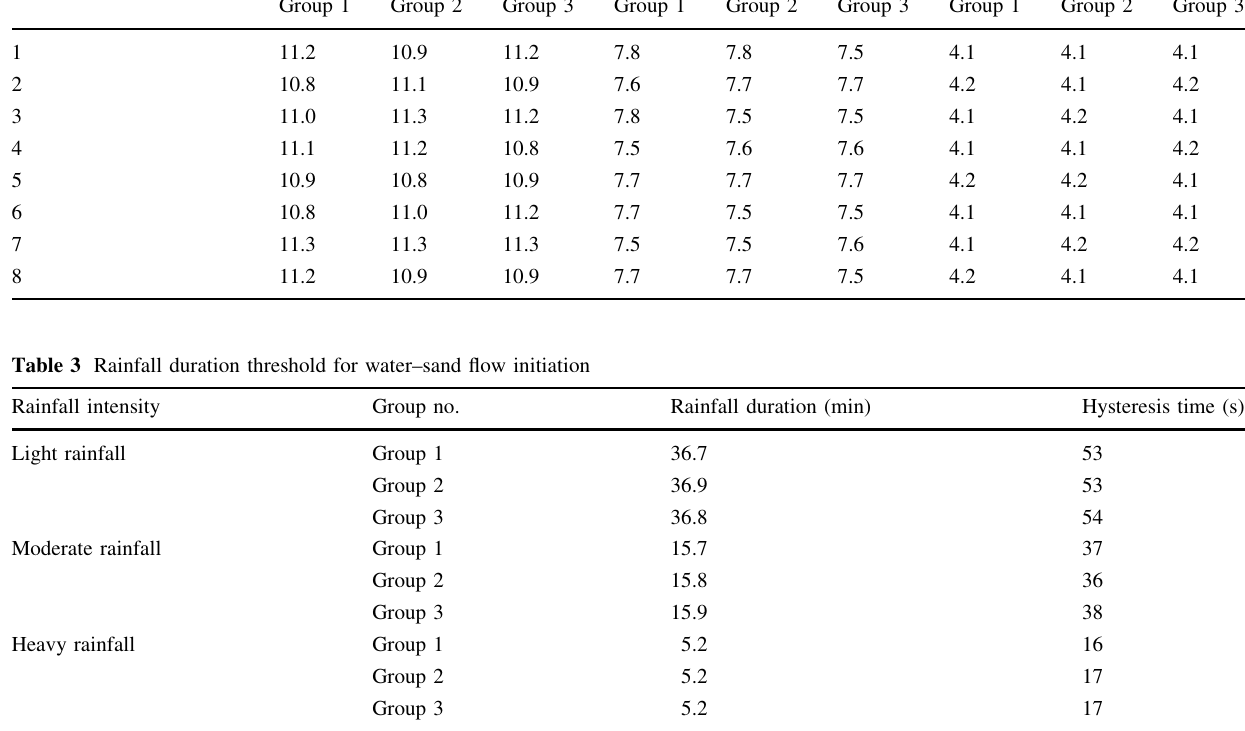
Table 2 Rainfall amount threshold for water–sand flow initiation (mm) Rain collection device no. Light rainfall Moderate rainfall Heavy rainfall